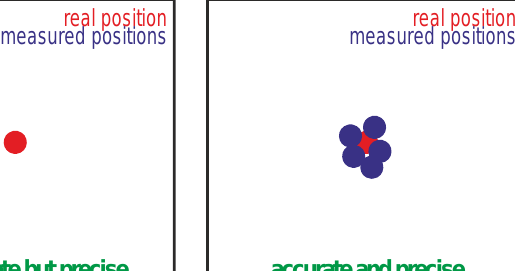
real position measured positions